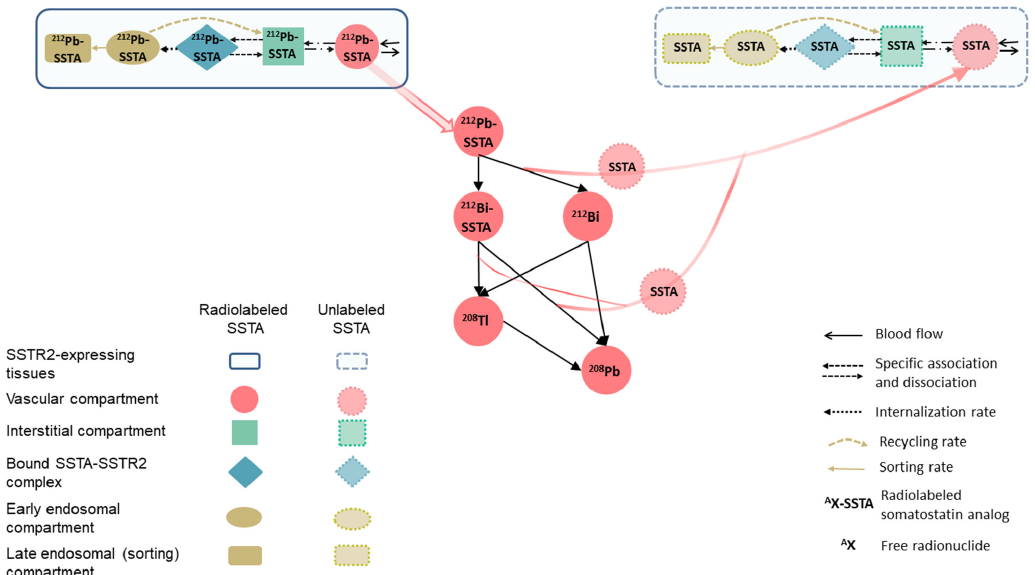
Figure 2. Scheme of the distribution of unlabeled SSTA in SSTR2-expressing tissue in the 212 Pb-SSTA-PBPK model. The injected SSTA with radiolabeled SSTA, the SSTA produced after the dissociation of a fraction of 212 Bi-chelator complexes after beta decay of 212 Pb and the SSTA produced after alpha decay of 212 Bi and 212 Po are distributed in tissues via blood flow. The distributed SSTA were assumed to follow the same PK of radiolabeled SSTA and both compete on free binding sites. The structure of non-SSTR2-expressing tissues for unlabeled SSTA is the same as the one for radiolabeled SSTA.